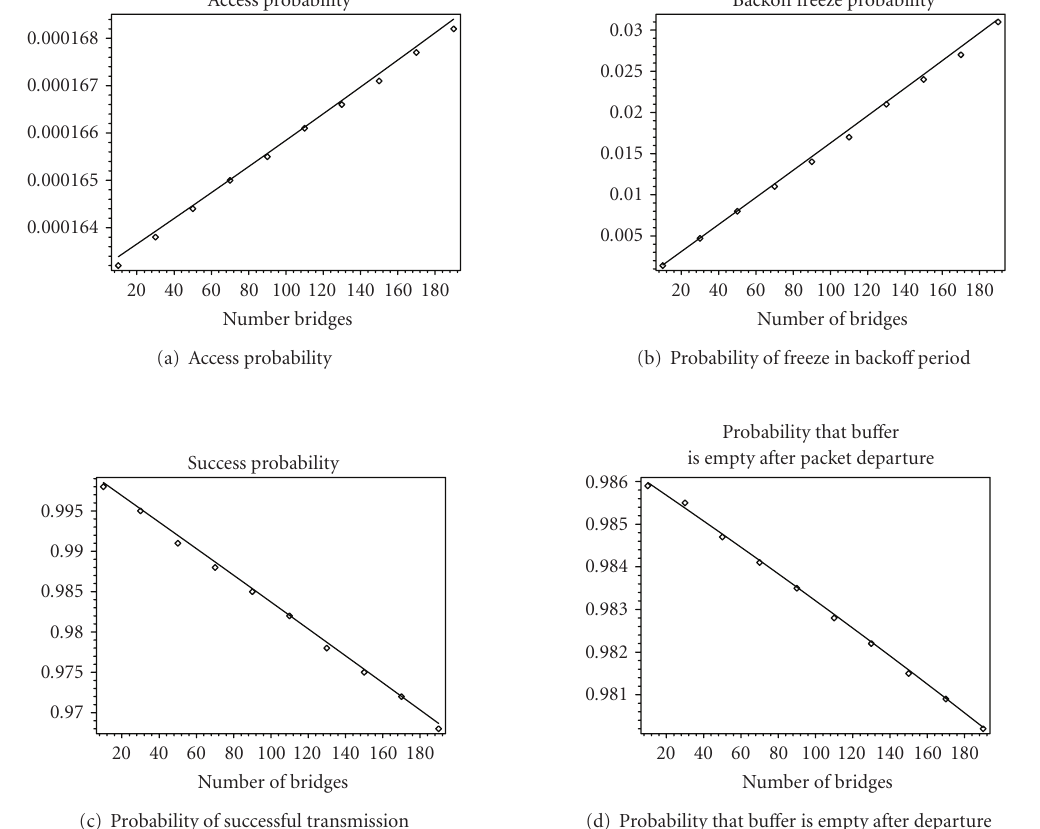
Figure 5: Access probability, probability that backo ff count will be frozen, probability of successful transmission, and probability that bu ff er is empty after departing packet. Analytical results are shown as lines and simulation results are shown as points.